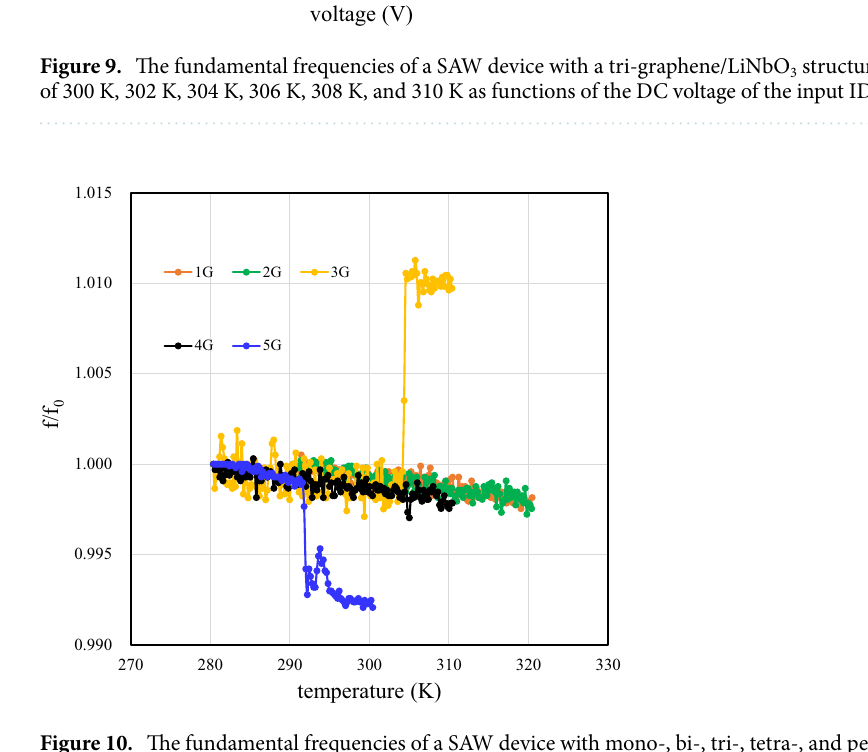
Figure 10. The fundamental frequencies of a SAW device with mono-, bi-, tri-, tetra-, and penta-layers as functions of the temperature. Here, the frequencies are divided by the f 0 of the penta-layer sample at 280